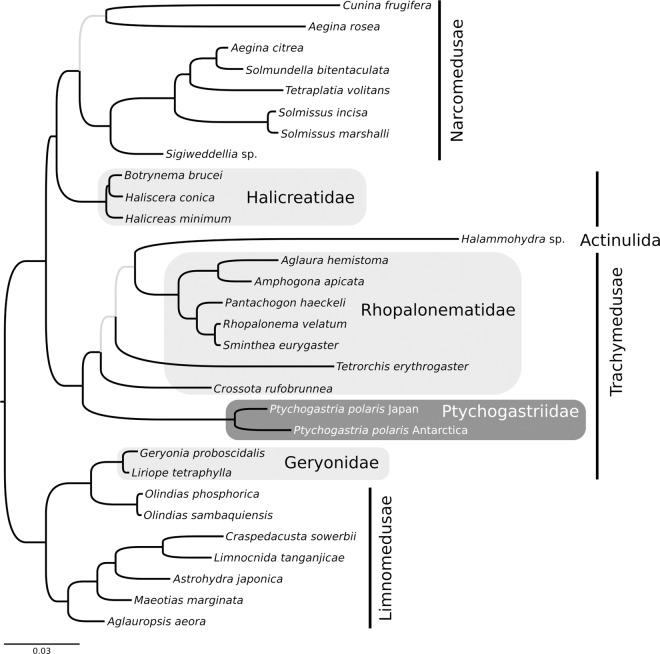
Bayesian phylogenetic hypothesis of Trachylina, including Ptychogastria polaris.The phylogenetic tree was rooted on Limnomedusae following [47]. Branches in black indicate a posterior probability ≥ 0.95 while grey branches represent a posterior probability < 0.95. The families of Trachymedusae are highlighted in grey. Note that the P. polaris specimen from Antarctica is lacking a 16S sequence.